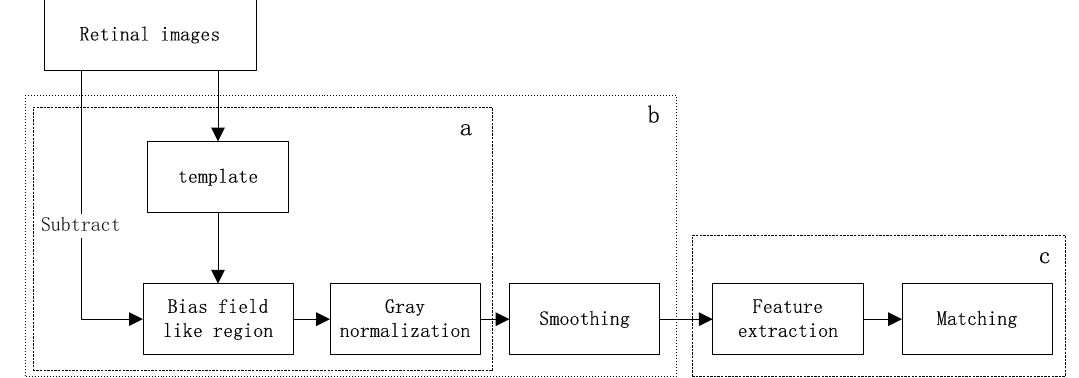
Figure 1. Flowchart of the proposed method. ( a ) Background uniformation; ( b ) preprocessing; ( c ) SIFT based recognition. Retinal images template regionSubtract Bias field like